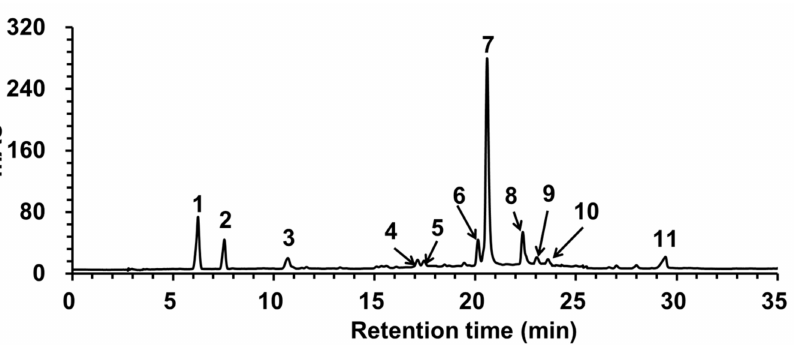
Figure 4. The RP-HPLC spectrum of thiolytic degradation products of the 70% acetone eluent of the rhizome of F. dibotrys